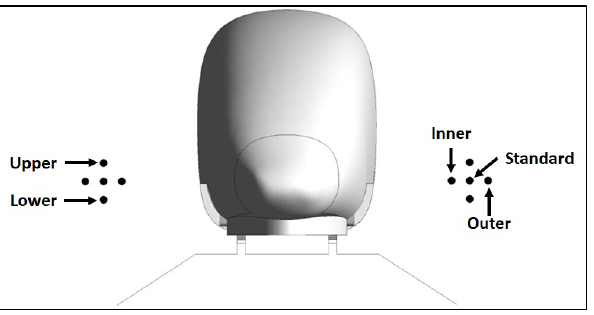
Figure 4. Location of five sample lines on each side of the